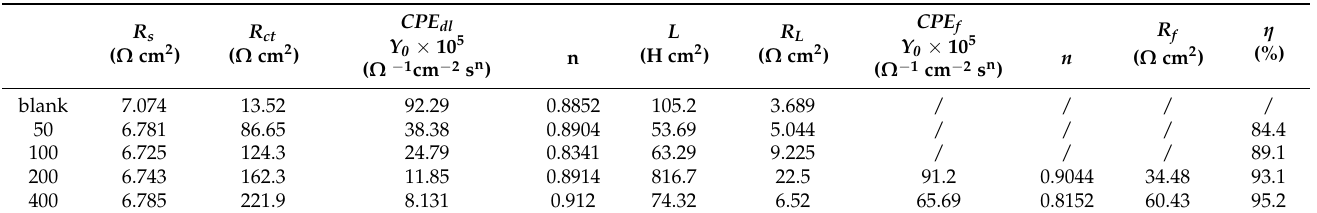
Figure 5. The equivalent circuit models used to fit the EIS results. Table 1. Electrochemical parameters obtained by fitting the EIS results with equivalent circuits.